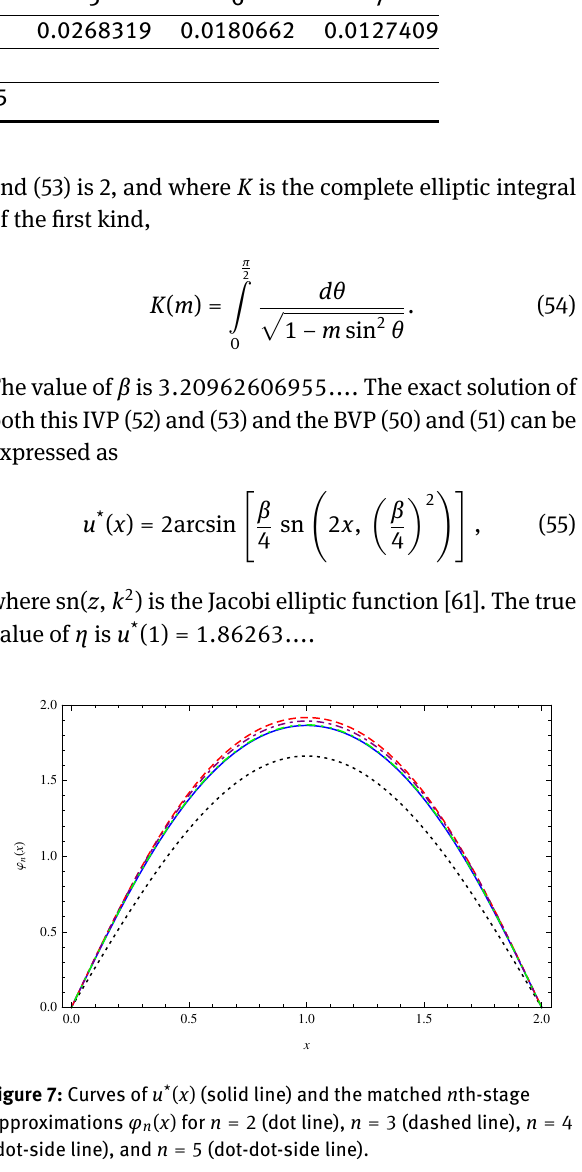
We take β = 3.20962607 and plot the curves of the ex- act solution u * ( x ) and the matched n th-stage approxima- tions φ n ( x ) for n = 2, 3, 4, 5 in Figure 7, where the curves of u * ( x ) and φ 5 ( x ) overlap. The curves of the error